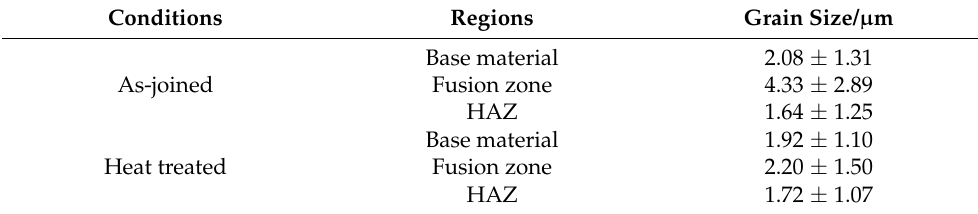
Table 1. Average grain size of different regions obtained from EBSD data in Figure